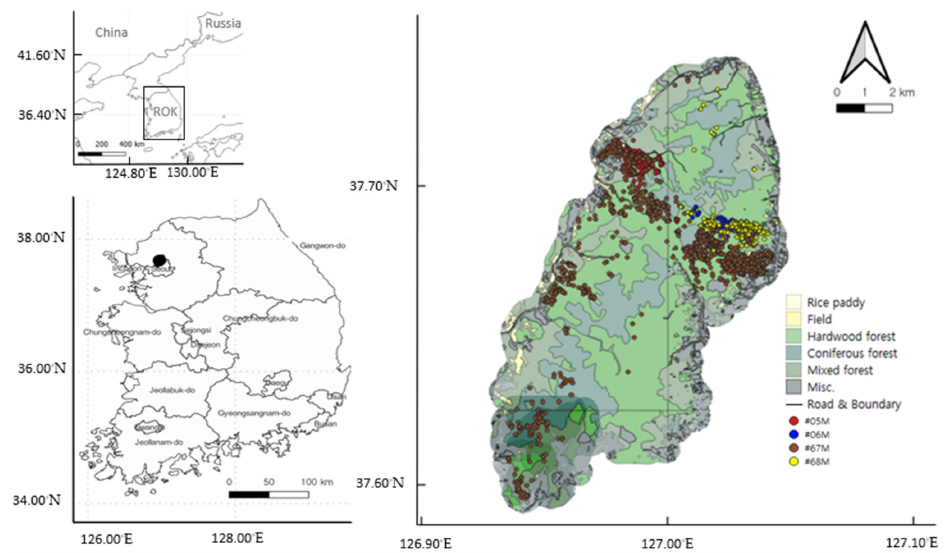
Figure 1. Survey area and movement locations of wild boar individuals based on telemetry data during the survey period in Republic of Korea (ROK). (Inset in the top left subfigure presenting ROK (Republic of Korea (mainland)), and the area with black color in bottom left subfigure indicating the Bukhansan mountain for the survey) Individuals were selected to monitor different representative life-history stages in different periods (Appendix A Table A1) Movement coordinates of wild boar individuals were continuously tracked at approximately two-hour intervals at the Bukhansan Moun- tain (Mt.) area in Seoul, Korea, from June 2018 to May 2019, using a GPS collar (Globalstar track, Lotek Inc. ® , Toronto, ON, Canada) (Appendix A). If the weight of the transmitter exceeds 5% of the body weight, it could affect the animal’s behavior [62]. Therefore, in the present study, GPS collars weighing less than 2% of the body weight were selected to minimize the transmitter effect. Upon permission from the Korea National Park Service (KNSP) Authority following the Animal Protection Act (Law No. 16544) and Laboratory Animal Act (Law No. 15944), the boars were tracked under the guidance of the Korea National Park Research Institute (KNPRI) (#794; 20170406). Detailed survey methods fol- lowed guidelines prescribed by Sikes et al. (2016) [63].